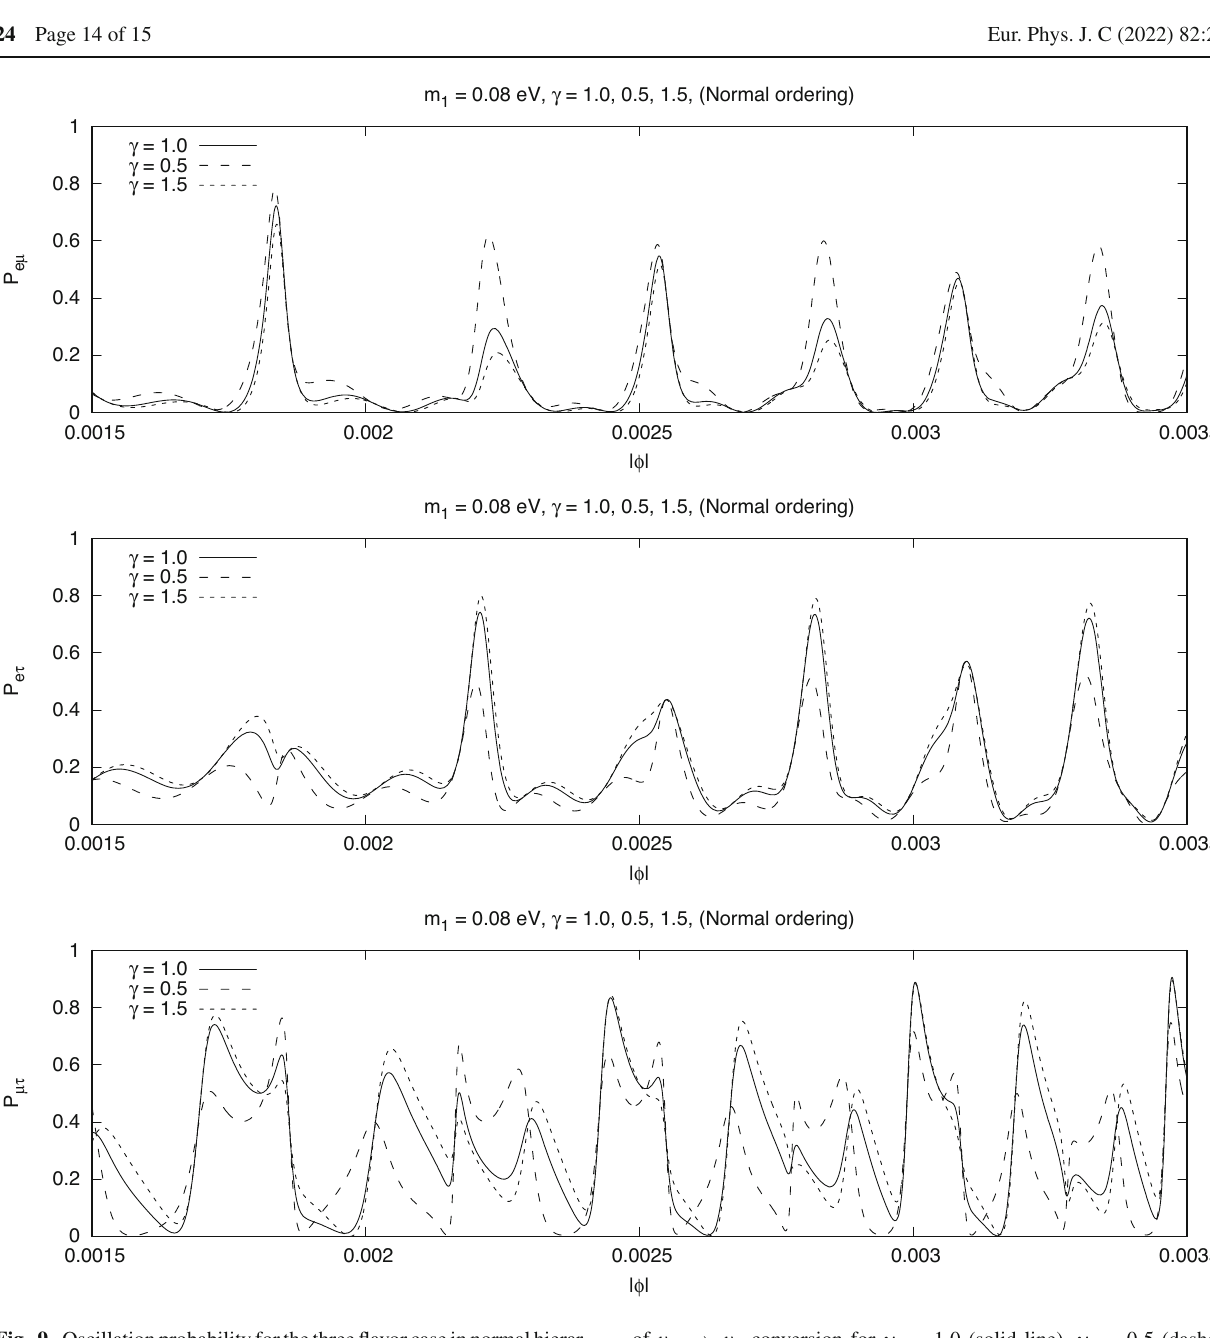
of ν μ → ν τ conversion for γ = 1 . 0 (solid line), γ = 0 . 5 (dashed line), γ = 1 . 5 (dotted line). We take r D = 10 8 km, r S = 10 5 r D , M ADM = 1 M (cid:15) and E 0 = 10 MeV. Neutrino mass squared differences, mixing angles and the Dirac CP phase are taken from the latest